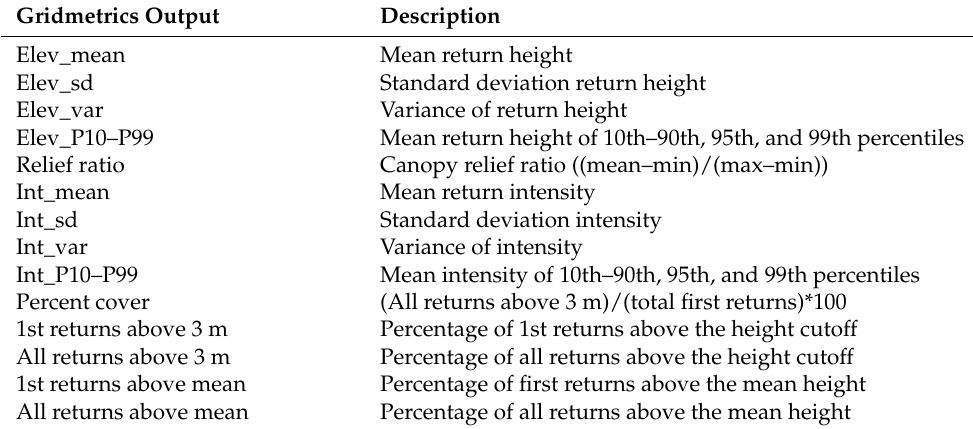
Table 1. LiDAR metrics used as the basis for model building. All metrics were generated with Fusion’s Gridmetrics tool in AreaProcessor. Except when otherwise specified, they represent first